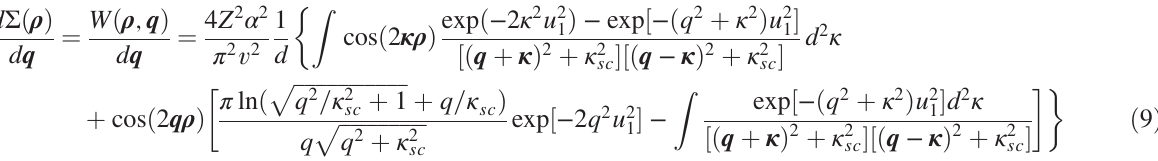
ffiffiffiffiffiffiffiffiffiffiffiffiffiffiffiffiffiffiffiffiffi p q 2 = κ 2